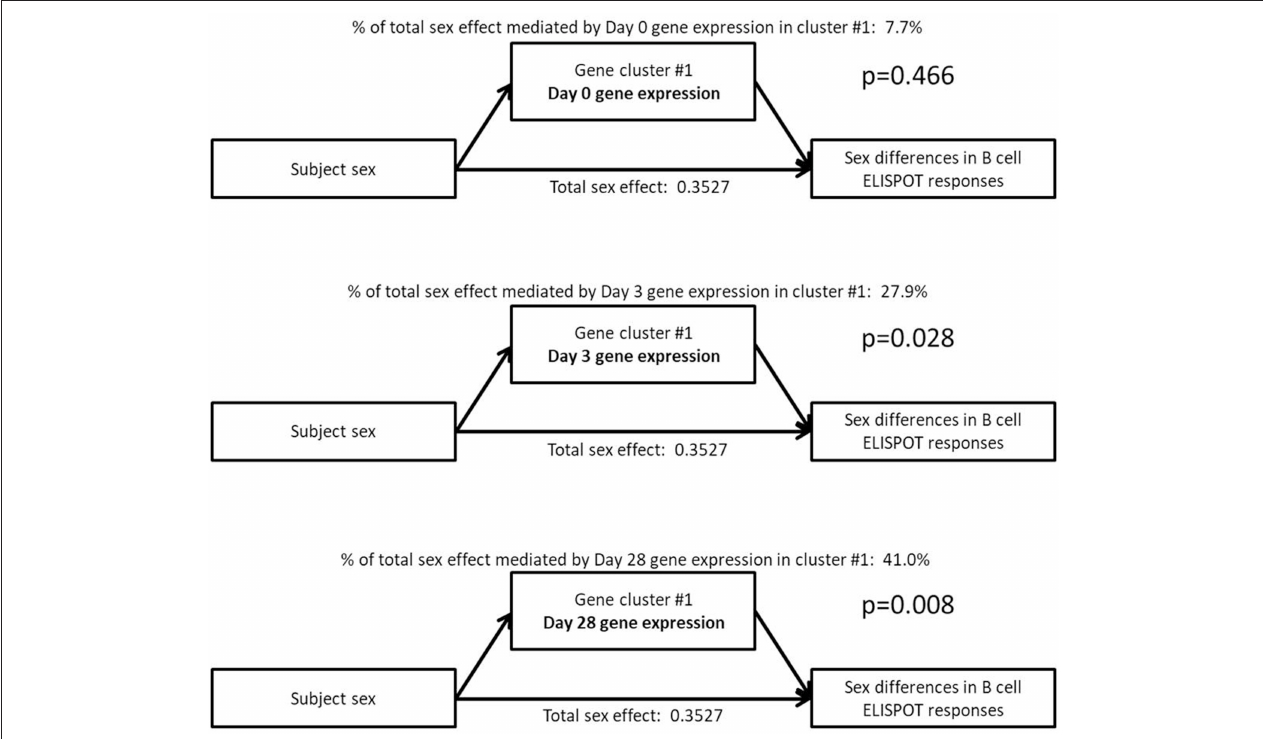
FIGURE 3 | Mediation analysis indicates that the sex effect on B-cell ELISPOT responses is mediated by Day 3 and Day 28 gene expression in a small gene cluster of 135 genes highly enriched for B cell-related genes. The total sex effect represents the fraction of the standard deviation in ELISPOT response that can be explained by sex.